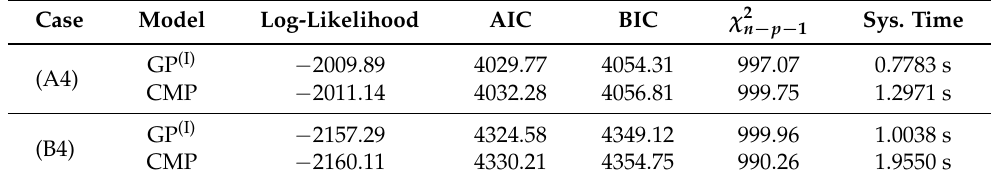
Table 9. Model comparisons based on 1000 replications for Cases (A4) & (B4). Case Model